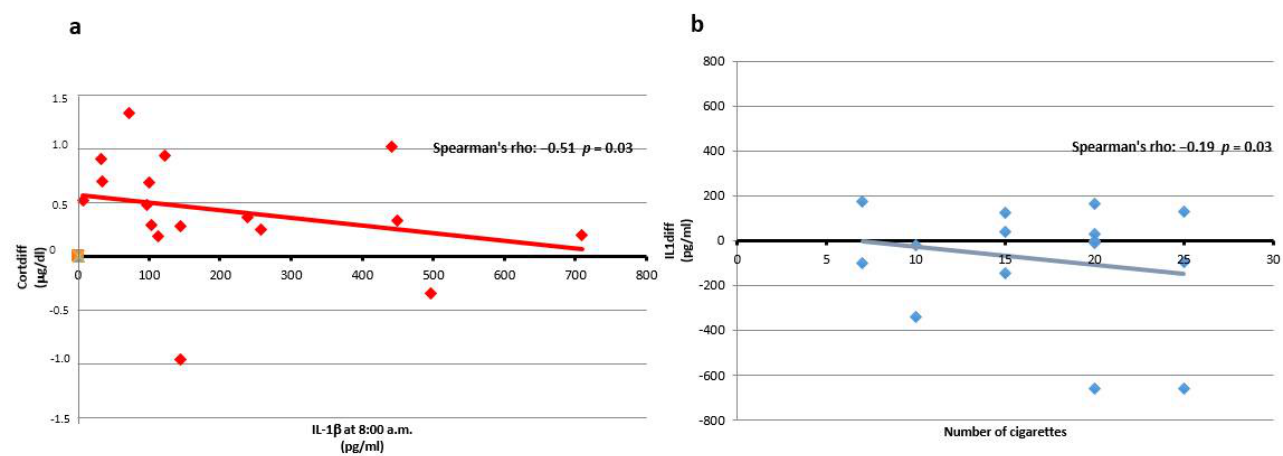
Figure 2. Correlations of IL-1 β with Cortdiff and number of cigarettes. ( a ) The negative correlation between IL-1 β levels at 8:00 a.m. (pg/mL) and Cortdiff ( µ g/dL) is shown with a Spearman’s rho = − 0.51 and p = 0.03. ( b ) The negative correlation between IL1diff and number of cigarettes is shown with a Spearman’s rho = − 0.19 and p = 0.03.